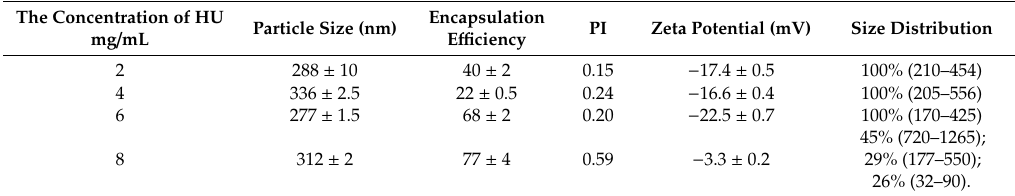
Table 2. Characteristics of HSA nanoparticles containing hydroxyurea.